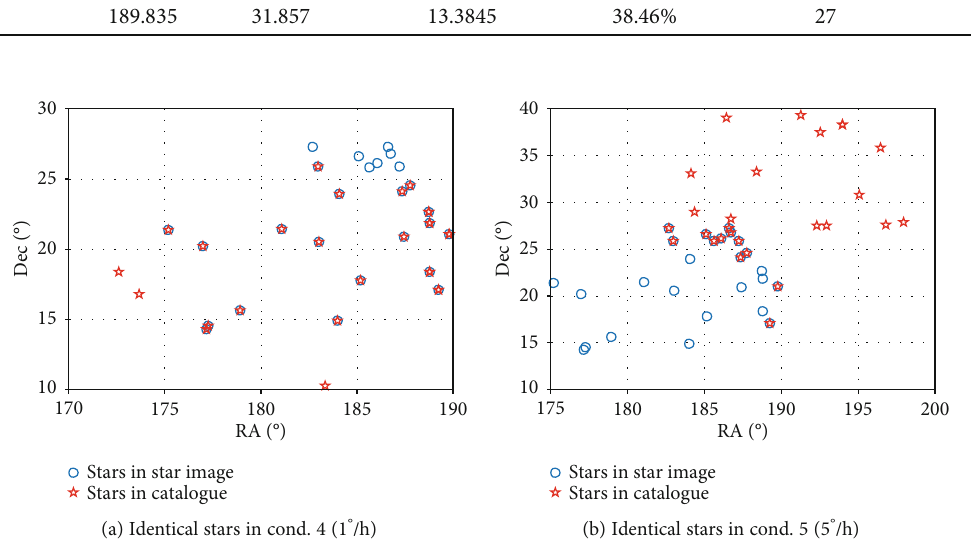
Figure 13: The identical stars in the 4060 s epoch.